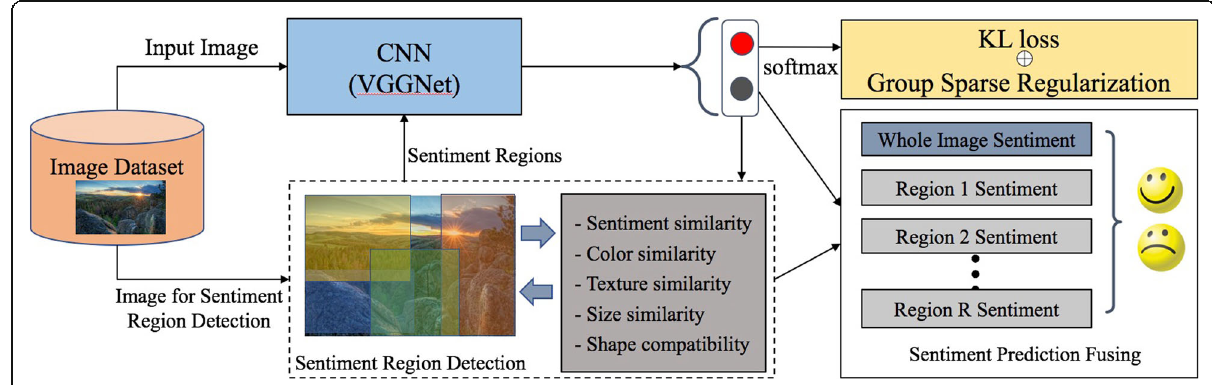
Fig. 1 The framework of our proposed R-CNNGSR